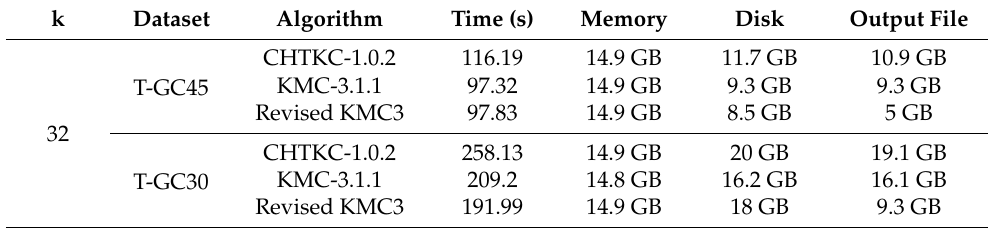
Table 6. Comparison of KMC3, CHTKC, and Revised KMC3 with various sequencing data (Memory quota 16